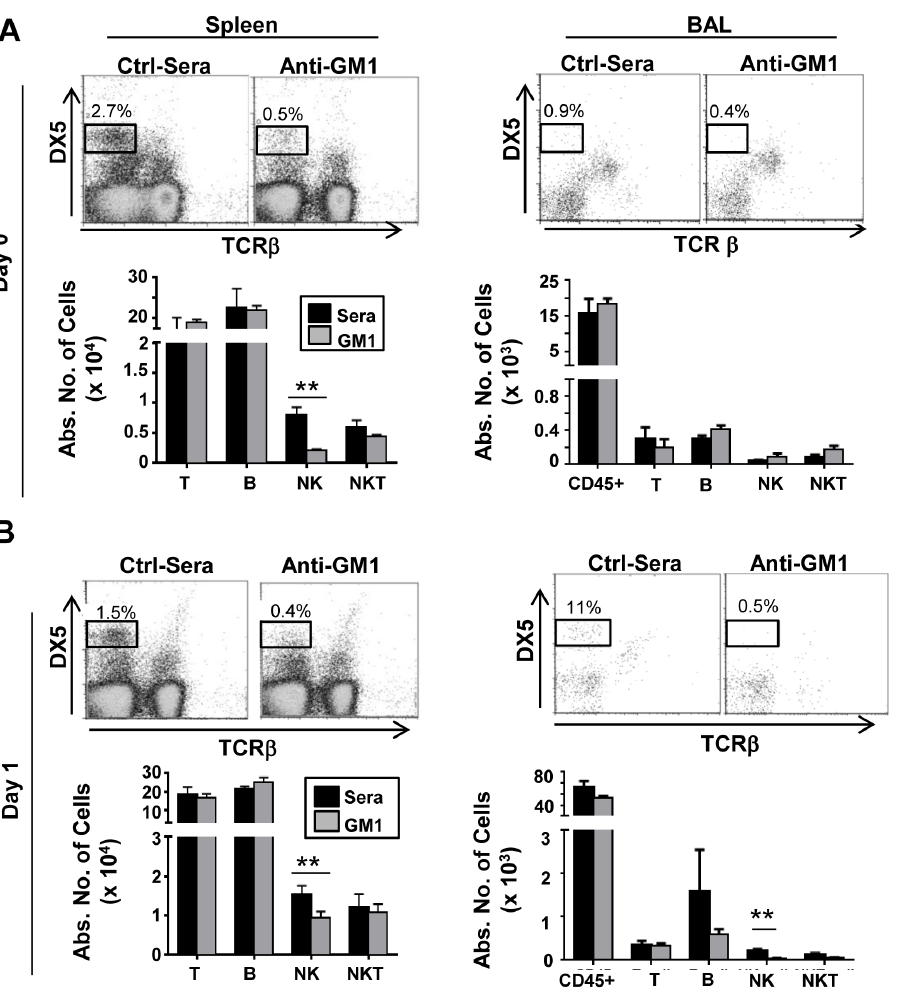
Figure 3. Pre-treatment with anti-asialo GM1 depletes NK cells in spleen and airways before bleomycin injection. Mice were injected with either anti-asialo GM1 or control rabbit sera at 2 24 h and 2 1 h before bleomycin administration ( A ) At day 0, before bleomycin injection, and ( B ) day 1 after bleomycin injection leukocytes were isolated from spleen and BAL fluid, stained and analyzed by flow cytometry. Leukocytes were identified by CD45 expression, and percentages and absolute numbers of T cells (TCR b + ), B cells (CD19 + ), NK cells (DX5 + TCR b -) and NKT cells (DX5 + TCR b + ) were determined. In the BAL fluid analysis in ( B ), a single value in the quantification of absolute T cell numbers (data point: 2,453 T cells) in the sera-control group was determined by Dixon’s Q test to be an outlier ( . 95% confidence), and was therefore excluded from subsequent analysis. Mean 6 SEM of n=4 mice per group. *p , 0.05, ** p , 0.01 by 2 way ANOVA followed by t -test.